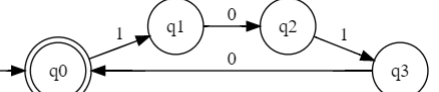
Figure 1. DFA recognizing Tomita’s 5th grammar.